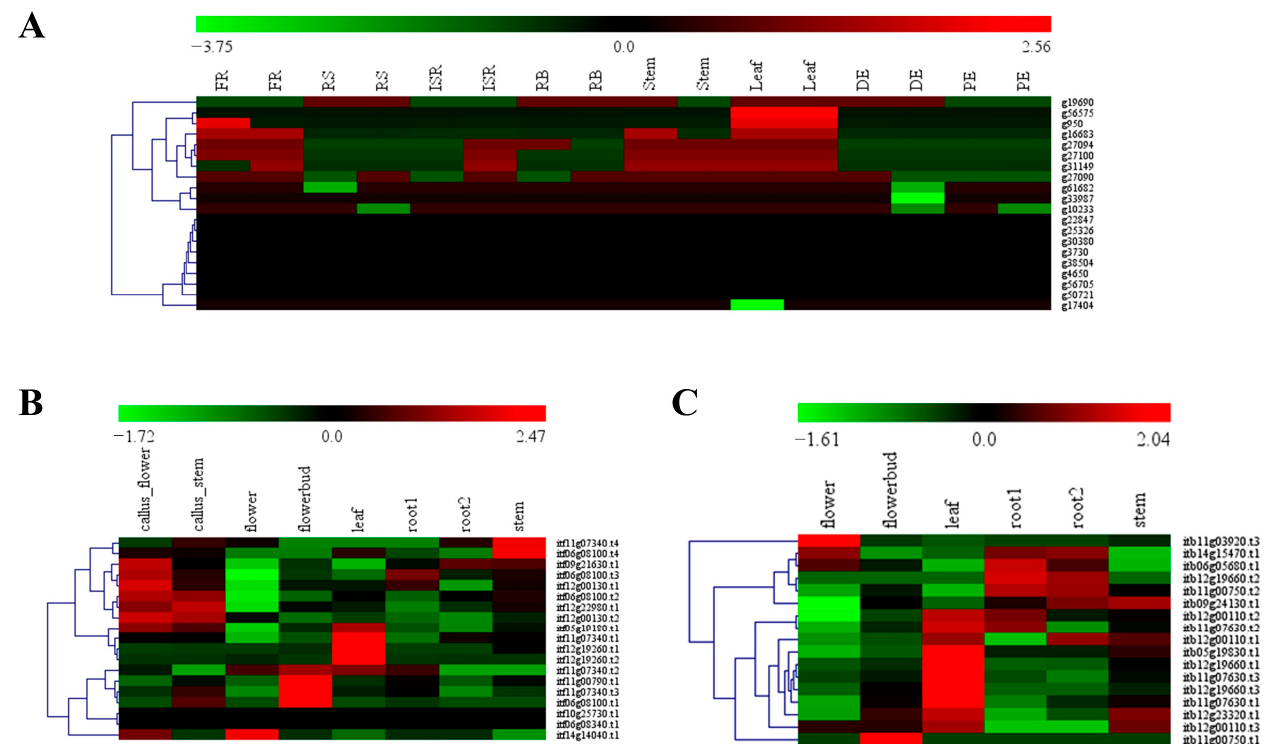
Figure 5. Heatmaps of expression profiles for nifH genes in multiple tissues: ( A ) Expression profiles of nifH genes in different sweet potato tissues: fibrous roots (FR), initiative storage roots (ISR), leaves, distal ends (DE), proximal ends (PE), root bodies (RB) and root stalks (RS); ( B ) Expression profiles of nifH genes in different I. trifida tissues: callus flowers, callus stems, flowers, flower buds, root1, root2, leaves and stems; ( C ) Expression profiles of nifH genes in different I. triloba tissues: root1, root2, flowers, flower buds, leaves and stems.